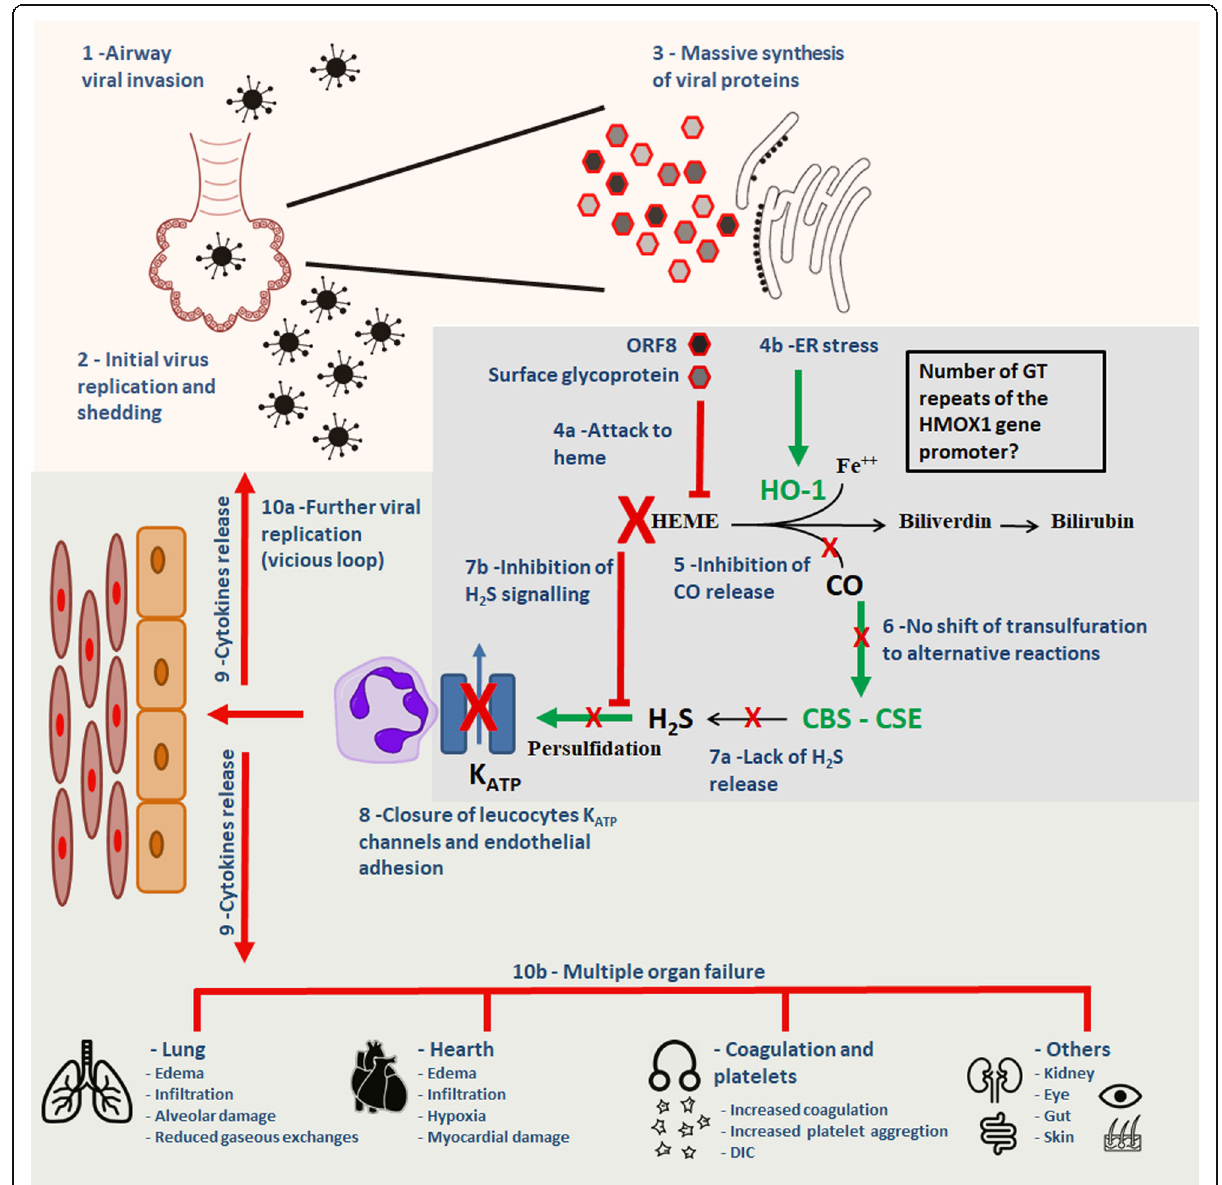
Fig. 2 Proposed model for the pathogenesis of Covid 19. 1 - The virus penetrates the airways and infects the bronchial and alveolar epithelium, other routes of invasion are possible (e.g. eye); 2 - The virus starts replication into the cell; 3 - Massive synthesis of viral proteints into the endoplasmic reticulum (ER); 4 - The ORF8 and surface glycoprotein start attacking and destroying the heme of heme proteins (4a) while the ER stress caused by massive protein synthesis activates the physiologic HO-1 response (4b); 5 - The activation of HO-1 fails to work due to substrate (heme) inhibition by viral proteins; 6 - In absence of CO from HO-1 there is no shift of transulfurations to alternative reactions and failure to release H 2 S; 7 – Hampered H 2 S release from CBS/CSE (7a) inhibits their persulfide forming activity while destruction of the heme by viral proteins (7b) further decreases H 2 S effects by inhibiting its persulfidation signalling; 8 - Due to low H 2 S-induced persulfidation, the K ATP channels of leucocytes closes down, which triggers leucocyte adhesion to the endothelium; 9 - The adhesion of leucocytes is followed by massive release of inflammatory cytokines, both local and systemic; 10a - Inflammation induced by cytokines further feeds viral replication amplifying the effects in a vicious loop; 10b - Inflammatory cytokines diffuse systemically and cause or exacerbate pre-existing damges in many organs and functions, mainly hearth and coagulation. Black box: Subjects with a strong HO-1 reaction (4b) are predicted to overcome the viral aggression and to exert an asymptomatic or pauci-symptomatic disease; Subjects with a defective genetic background, e.g. weak expression of the HMOX1 gene coding for HO-1, may suffer critical or fatal Covid